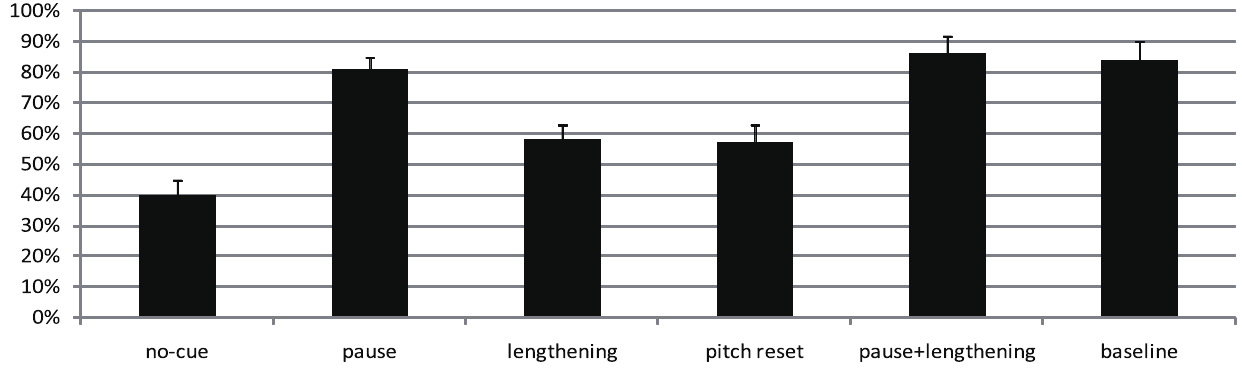
Figure 2. Proportions of the boundaries detected in the six experimental conditions (Error bars represent standard error of the mean).